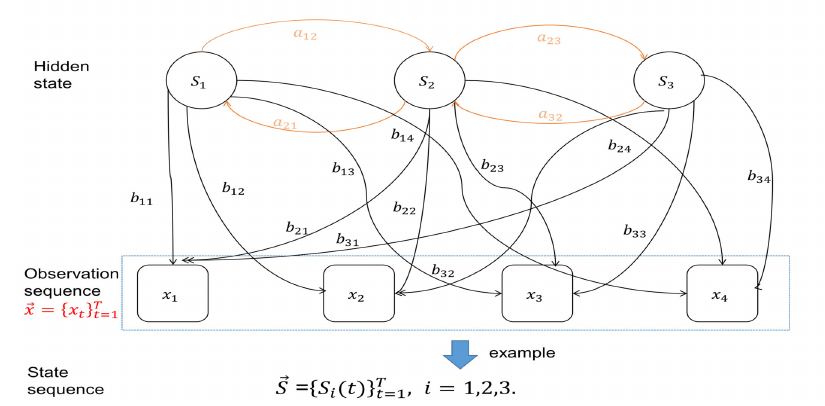
Figure 4. Schematic of the